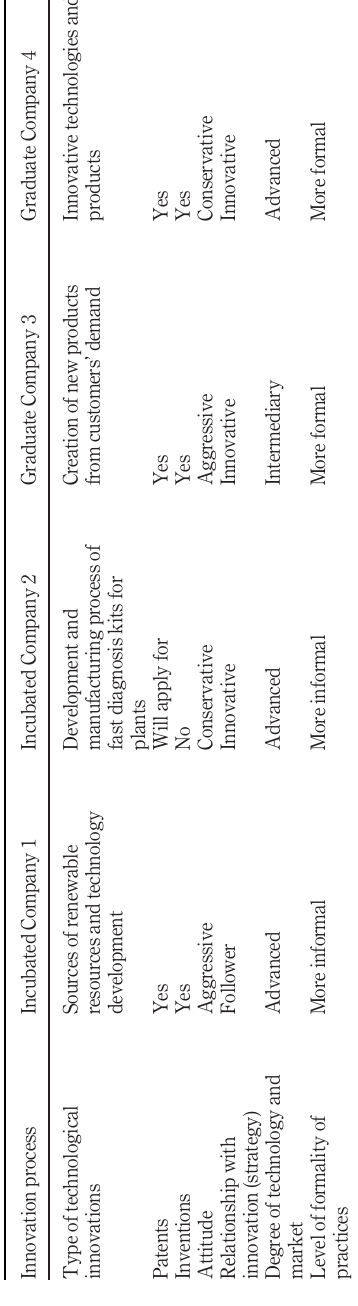
Table II. Characteristics of TBCs ’ innovation